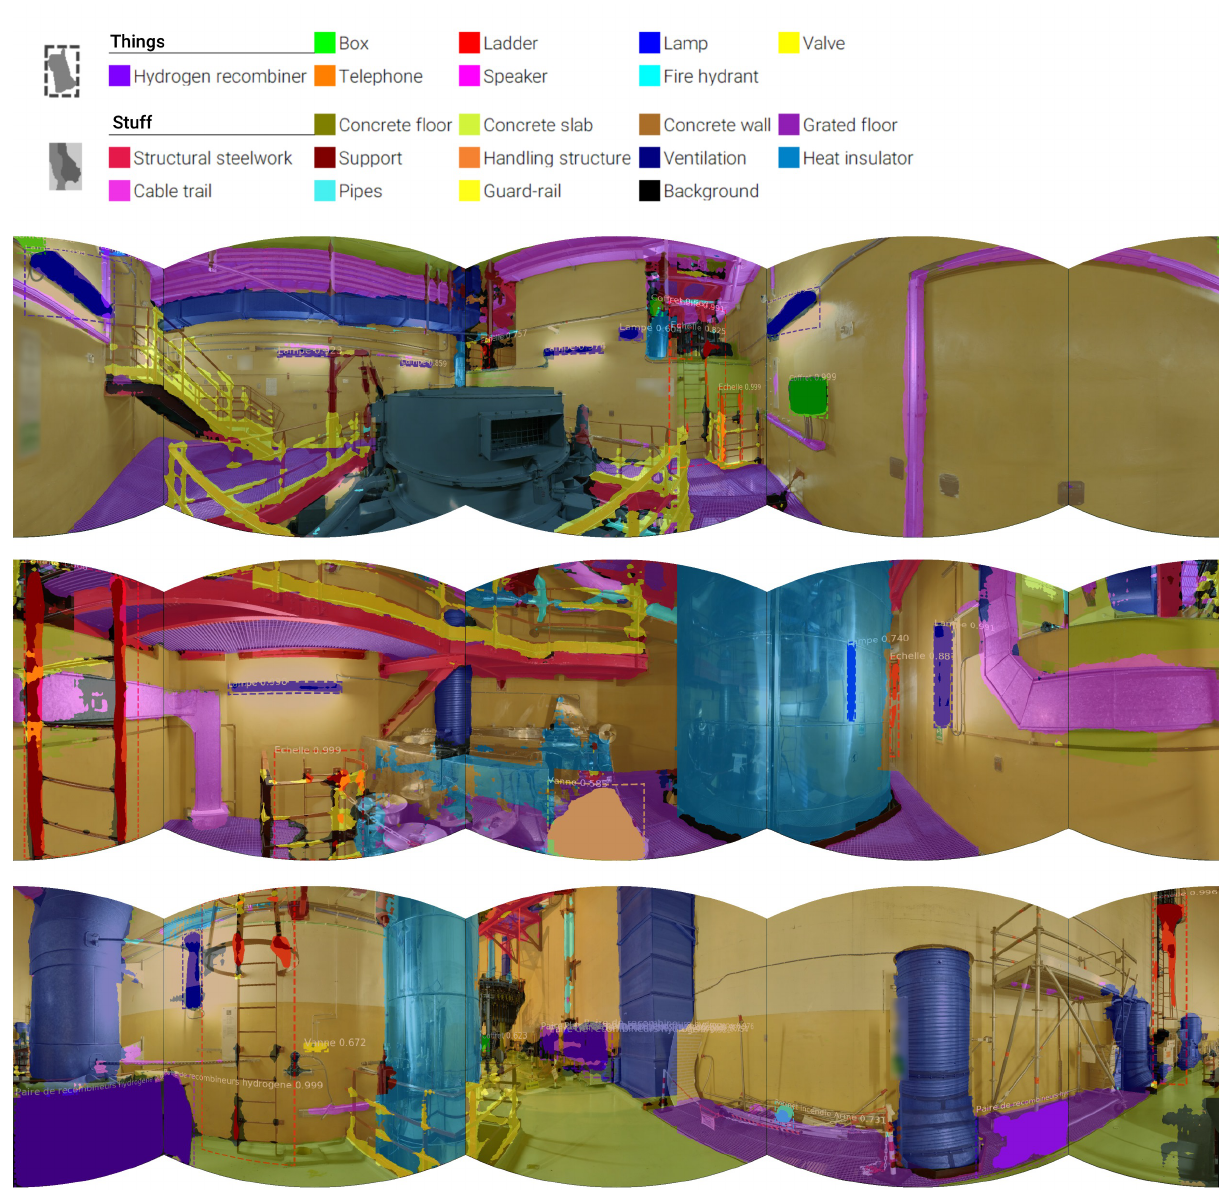
Figure 12. Examples of panoramas with predictions of things and stuff